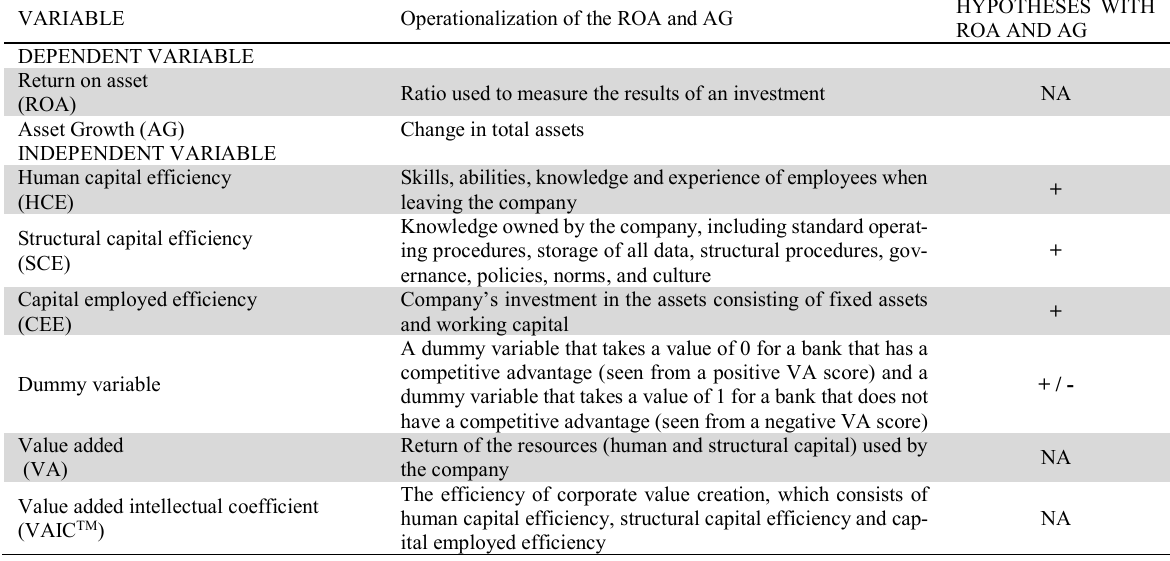
Operationalization of Variables used in the Regression Equation VARIABLE Operationalization of the ROA and AG